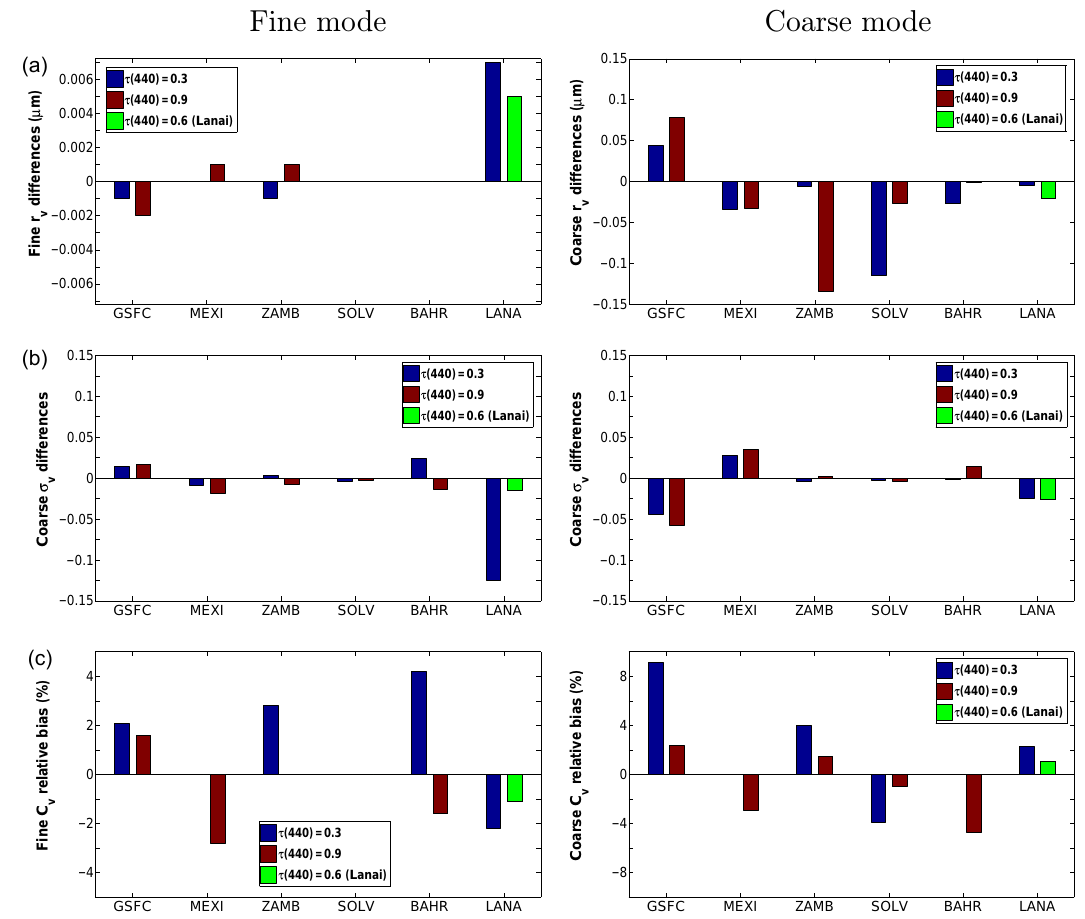
Figure 6. Differences between the averaged values obtained in the error simulation study (Table 7) and the retrieved values from the self- consistency analysis (Table 3) for the six parameters that describe the bimodal log-normal size distributions: volume median radius (top subfigures), geometric standard deviation (middle subfigures) and volume concentration (bottom subfigures). The differences for the latter are plotted in relative